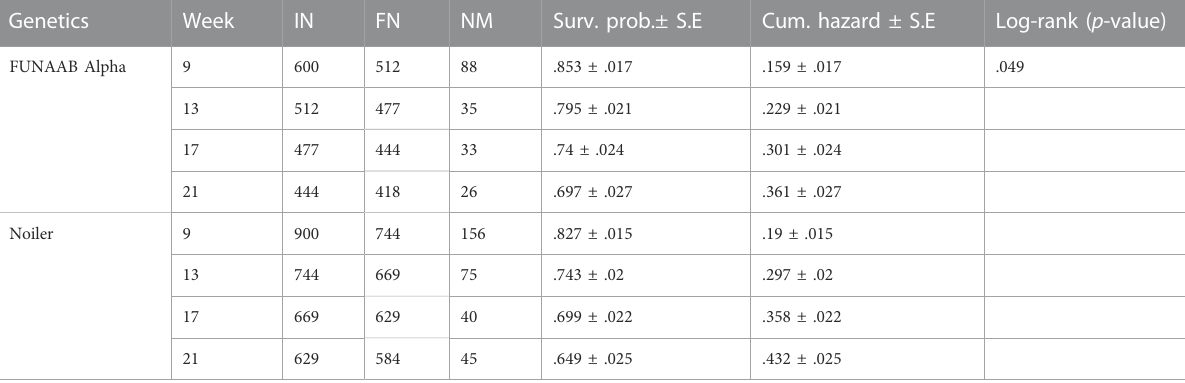
TABLE 4 Effect of genetics on survival performance of birds (5 – 21 weeks).